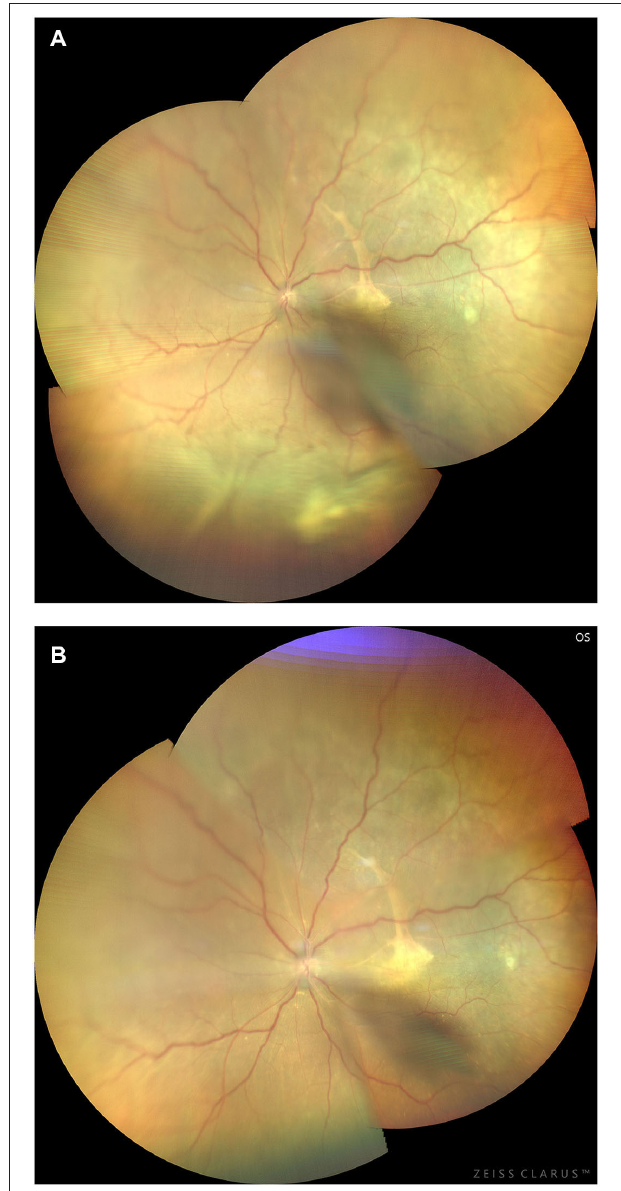
FIGURE 14 | Preoperative (A) and 3-month postoperative (B) retinal images (montage, CLARUS 500; Carol Zeiss) of an eye with type 1 UES. Note that the retinal detachment with choroidal swelling extending posterior to the equator in the inferior quadrants, and a subretinal proliferative membrane and macular fold are observed (A) . Total resolution of the retinal detachment and choroidal swelling (B) was achieved 3 months after quadrantic lamellar-sclerectomy with sclerostomy in the inferior